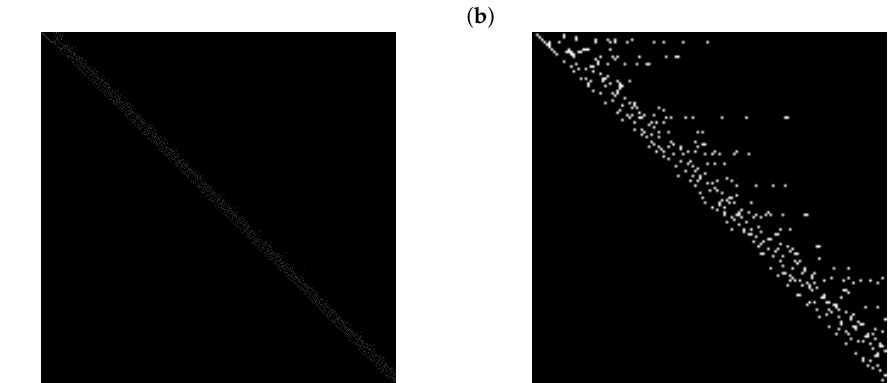
Figure 7. Example of the single image adjacency matrix: ( a ) with 1147 created superpixels, ( b ) with 146 created